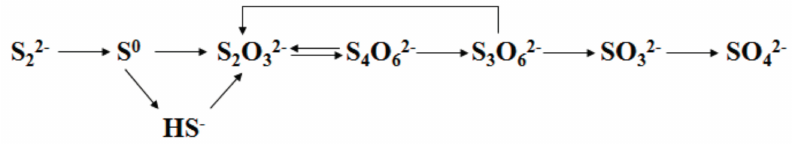
Figure 5. Oxidation route of sulfur in